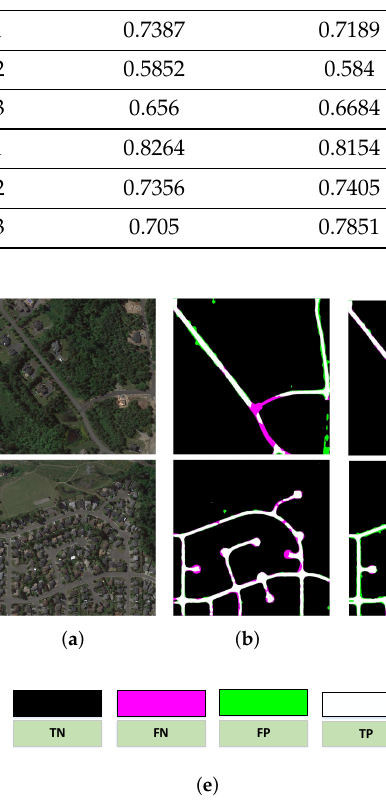
Figure 5. Some qualitative results on dataset 1. ( a ) The original satellite images; ( b ) the results of D-linknet; ( c ) the results of MD-ResUnet; ( d ) the results of our method; ( e )